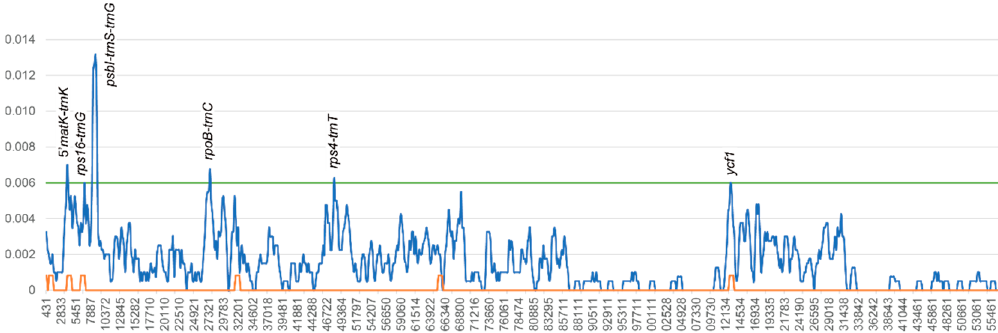
Figure 6. Nucleotide diversity graphs of Rosa chloroplast genomes. The x-axis represents the base sequence of the alignment, and the y-axis represents Pi value. The blue line indicates the nucleotide diversity of five Rosa chloroplast genomes; the orange line indicates the nucleotide diversity of the Synstylae chloroplast genomes; and the green line indicates the threshold for variation hotspots (Pi threshold = 0.006). Each variation hotspot for Rosa chloroplast genomes is annotated on the graph.